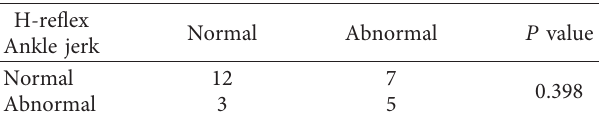
Table 8: Association between abnormal ankle jerk and abnormal H-reflex.